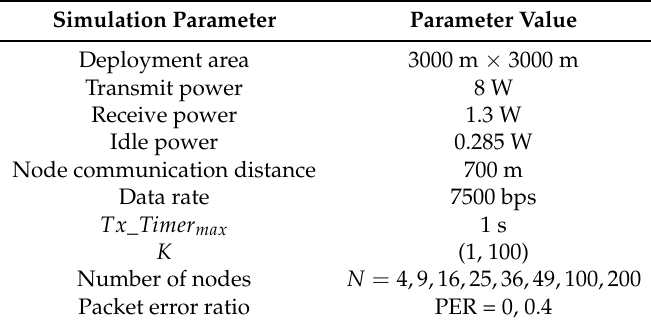
Table 4. Network Simulation Parameter